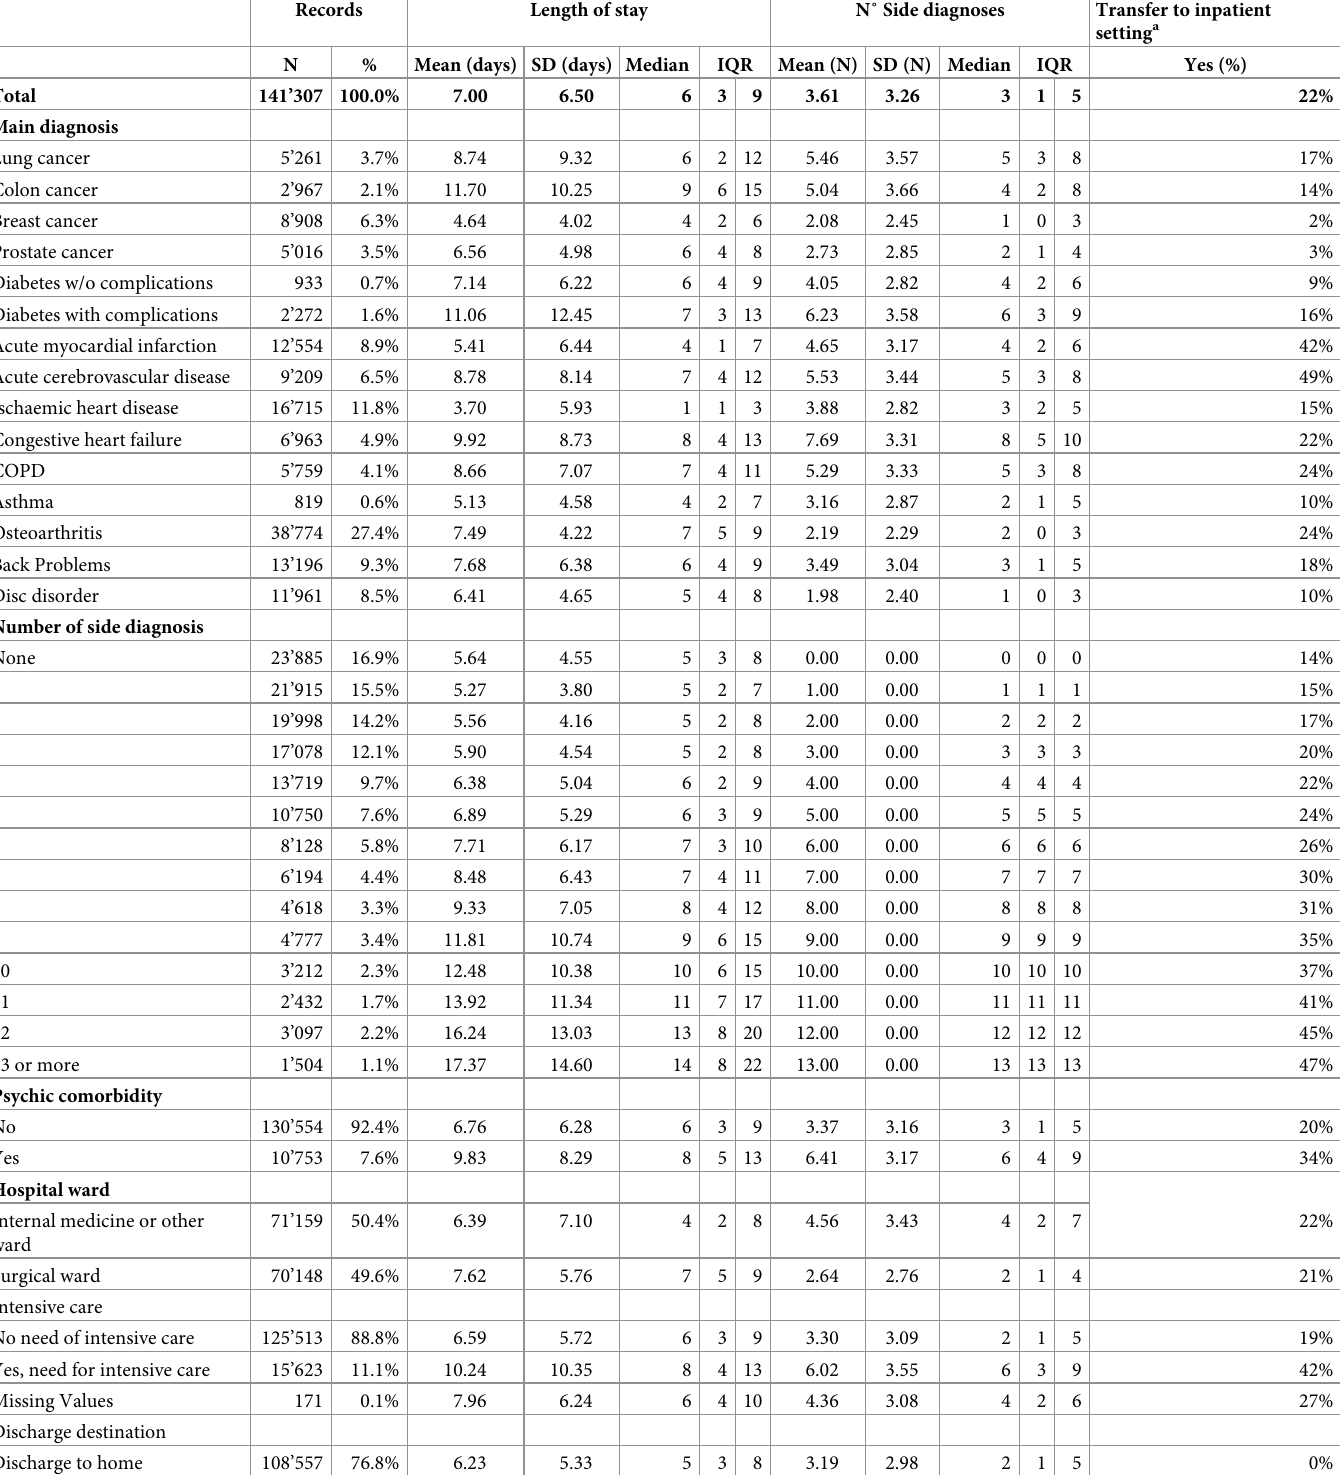
Table 3. Distribution (N records, %) of variables related to health status and hospital stay with descriptive statistics (mean (SD), median (IQR)) of length of stay and number of side diagnoses and percentage (%) of transfer to inpatient setting =